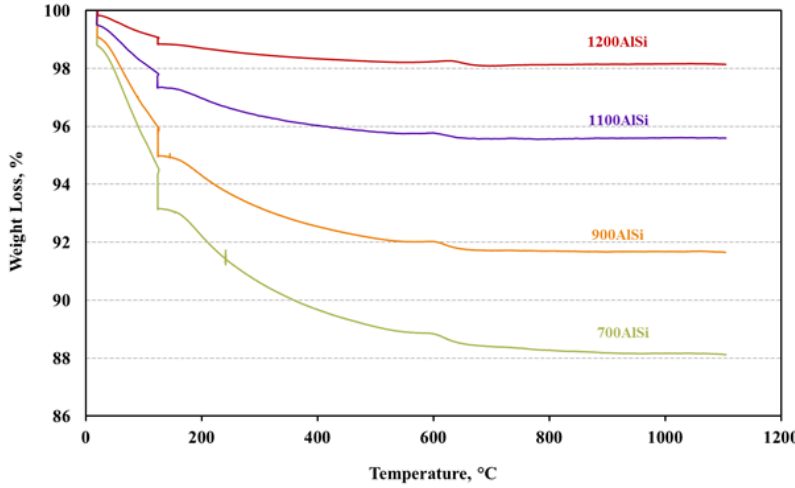
Figure 5. Thermogravimetric analysis (TGA) curves of supports calcined at different temperatures. Based on the values of concentrations of physisorbed water and OH groups (Table 5) for supports pretreated at different temperatures, it is clear that the higher the support pretreatment temperature, the lower the physisorbed water and hydroxyl group content of the corresponding support. Consequently, 700AlSi has the highest hydroxyl group concentration (5.6 mmol/g) while 1200AlSi has the lowest (0.8 mmol/g). Due to the hydrophilic nature of calcined alumina, 700AlSi also has the highest physisorbed water concentration (3.7 mmol/g) while 1200AlSi has the lowest (0.6 mmol/g). Table 5. Concentrations of physisorbed water and OH groups for supports pretreated at different temperatures.